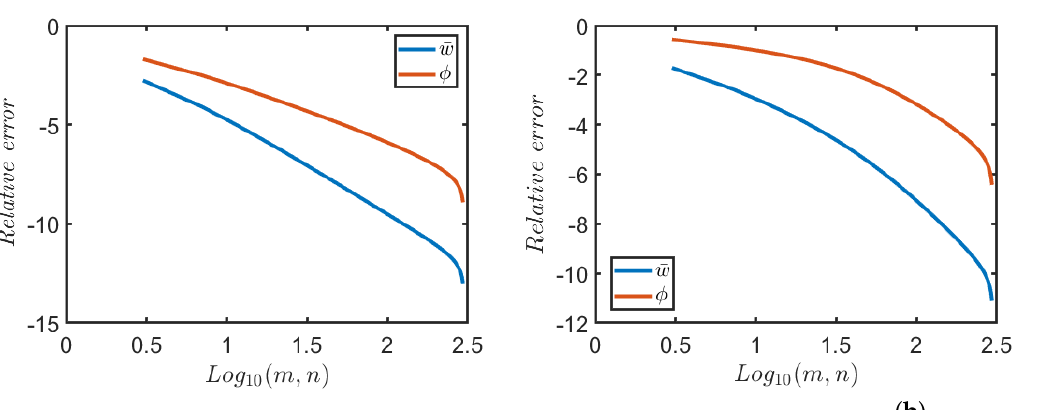
Figure 7. Convergence of the relative error on the displacement and potential at a square plate central point by increasing ( m , n ) for: ( a ) uniformly distributed mechanical load only; ( b ) uniformly distributed thermal load only.